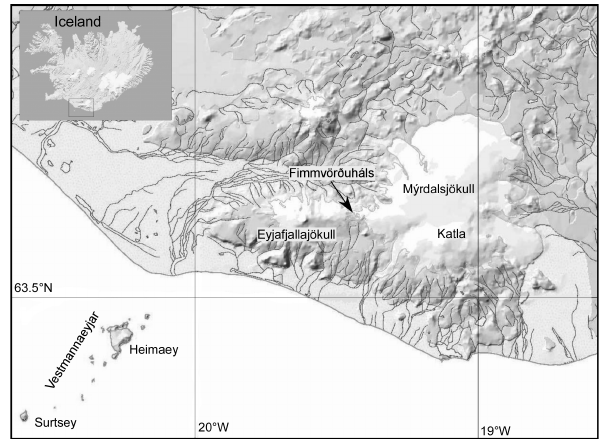
Fig. 1. Shaded relief map showing Eyjafjallajökull and Mýrdalsjökull ice-caps and the volcanic systems Vestmannaeyjar, Eyjafjallajökull and Katla. The pass between the two ice-caps, Fimmvörðuháls, was the location of the basaltic flank eruption pre- ceding the summit eruption of Eyjafjallajökull in